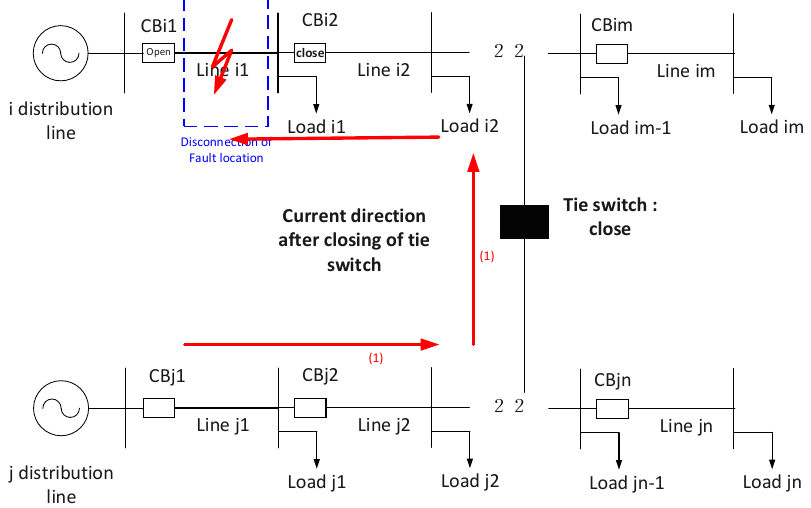
Figure 5. Current flow after the closing of the tie switch when the fault section is unsuccessfully disconnected.